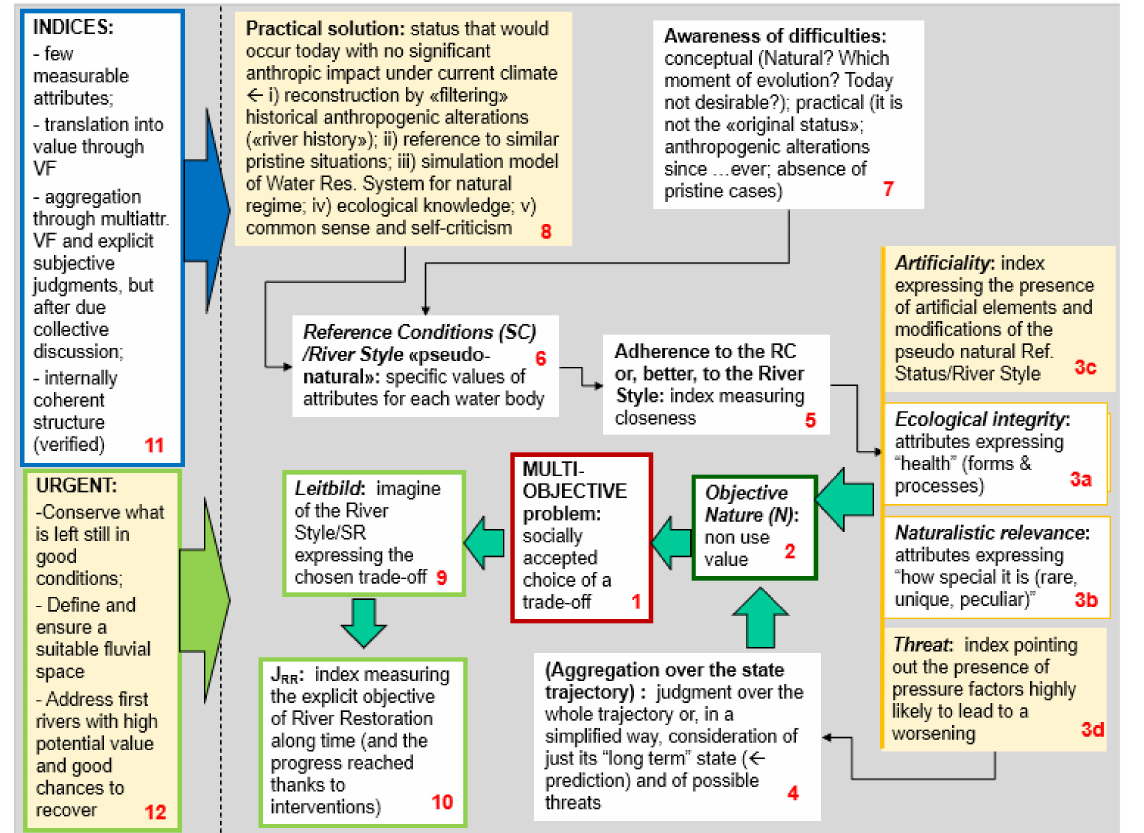
Figure 10. The reasoning and conclusions proposed in this paper are summarized in this figure: follow the numbering from the center towards the peripheral areas (the arrows mean “leads to”, “is cause of”, “is needed for”). The peripheral blocks on the left are intended to permeate the whole